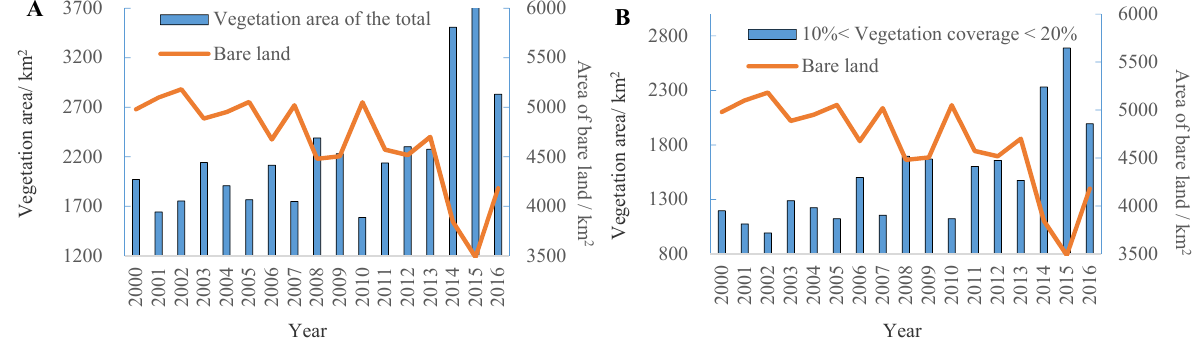
Figure 8. Vegetation coverage ( A ) and vegetation area ( B ) of the terminal of the Tarim River.